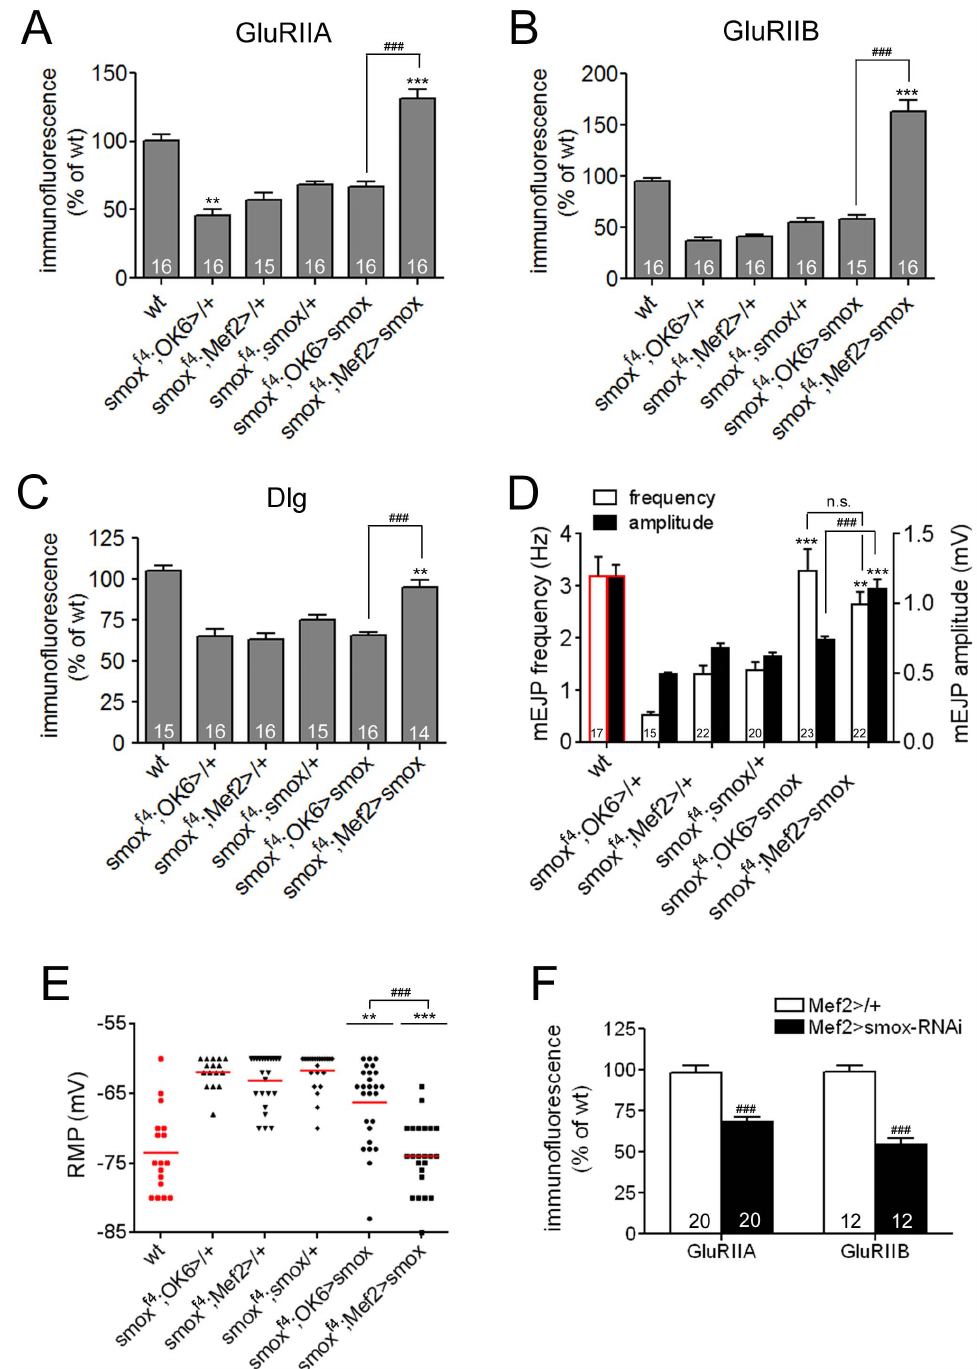
Figure 5. Muscle expression of smox transgene rescues the defective phenotypes of smox mutants. (A) Quantification of GluRIIA abundance. The decreased GluRIIA level exhibited by s mox mutants is rescued over the level of control animals ( smox f4 ; UAS- smox/ + ) and even the wild-type only when the smox transgene is expressed via the muscle driver, Mef2 -GAL4. (B) Quantification of GluRIIB level demonstrates a specific rescue by muscular expression of smox transgene. (C) The decreased level of Dlg is also restored by muscular expression of smox transgene. (D) Quantification of the size and frequency of mEJPs. Decreased mEJP size and frequency are restored in smox f4 ;Mef2- GAL4/UAS -smox animals. Note that expression of the smox transgene in motor neurons ( smox f4 ;OK6 -GAL4/UAS- smox ) most effectively rescues the decreased mEJP frequency. (E) Depolarized resting membrane potential of the smox mutants is fully restored by muscular expression of smox transgene. (F) Quantification of GluRIIA and GluRIIB abundance in control (Mef2 . / + ) and smox knockdown (Mef2 . smox -RNAi) animals. Error bars represent SEM. **p , 0.01, ***p , 0.001 from One-way ANOVA followed by Dunnett’s multiple comparison test. ### p , 0.001 from unpaired t-test. Each genotype was compared to smox f4 ; UAS - smox/ + . Additionally, smox f4 ;Mef2 -GAL4/UAS- smox was also compared to smox f4 ;OK6- GAL4 / UAS- smox. Data sets of wild-type shown in Fig. 2 were included in D and E for reference and marked with red.